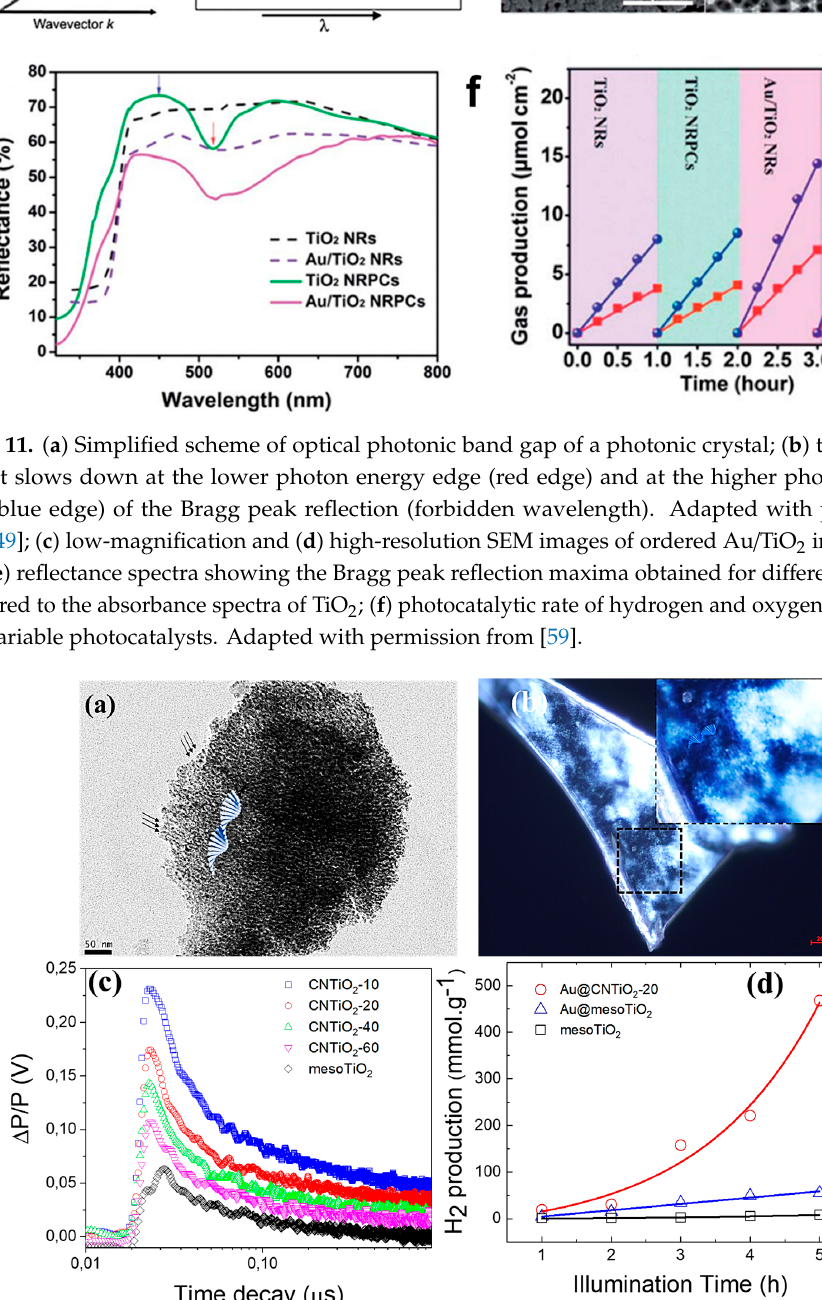
Figure 12. ( a ) TEM micrographs and ( b ) polarized optical microscopy images of TiO 2 film containing a replica of chiral nematic structure obtained by impregnation method; ( c ) Time-Resolved Microwave Conductivity (TRMC) signal of variable TiO 2 films under UV illumination showing the evolution of the charge carrier density produced upon UV laser excitation; ( d ) hydrogen production versus the illumination time showing the beneficial effect of chiral nematic structure on H 2 generation.